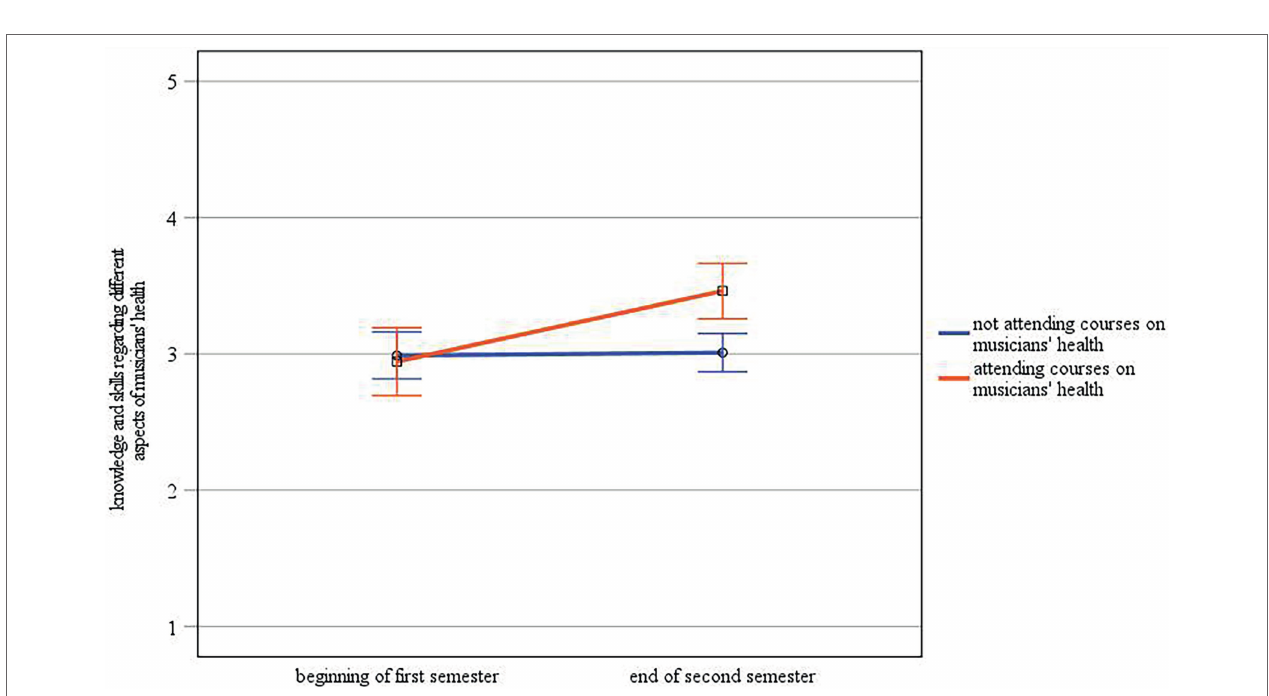
FIGURE 4 | Interaction between time and group concerning self-assessment of knowledge and skills regarding different aspects of musicians’ health (error bars represent 95% CI).